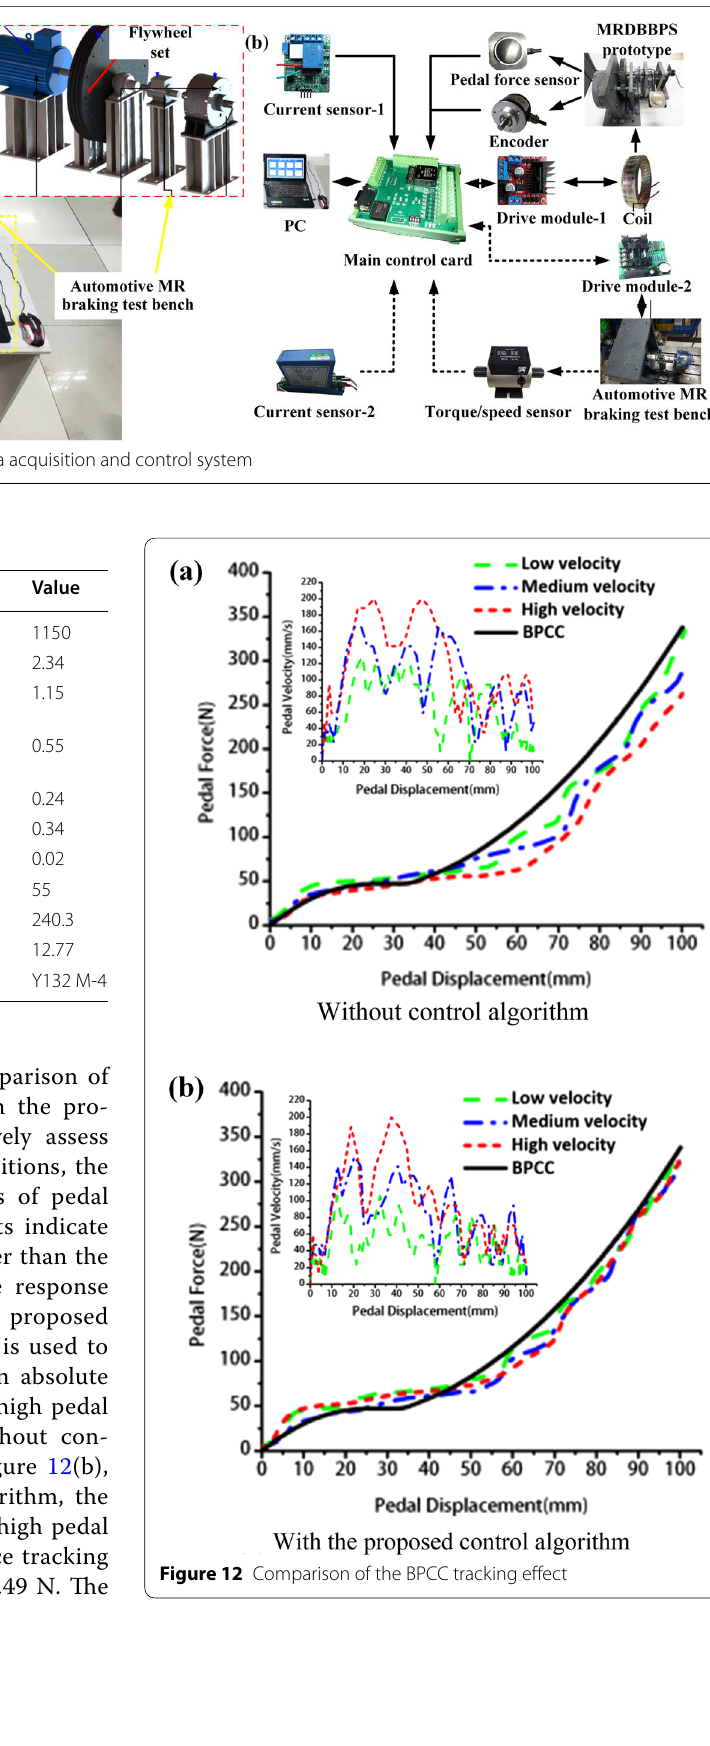
Figure 12 Comparison of the BPCC tracking